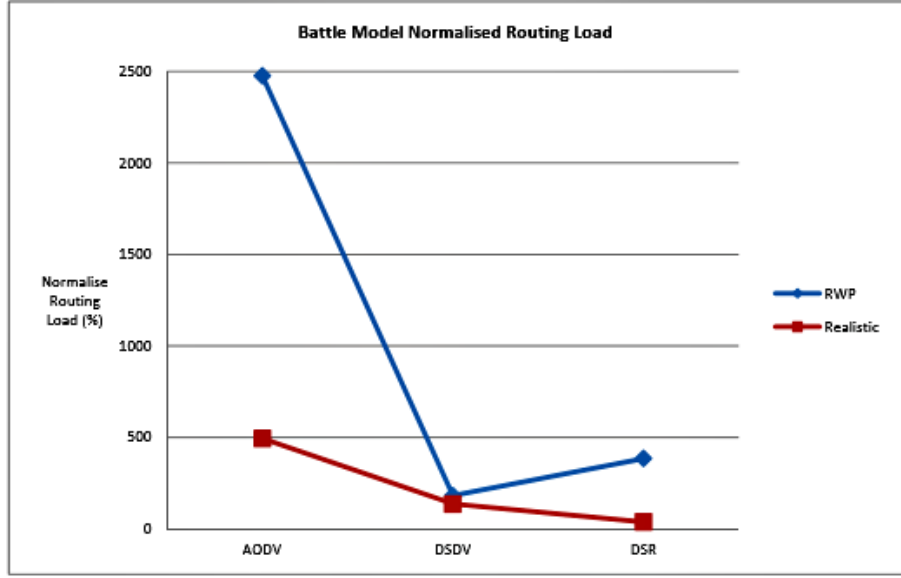
Figure 10. Normalized Routing Load for Battlefield Model.